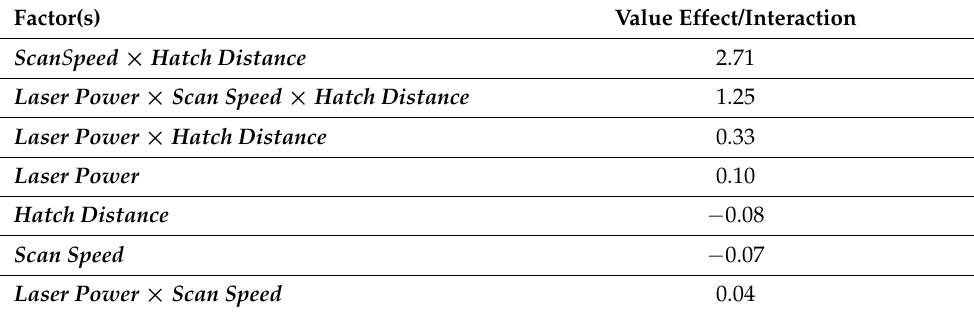
Table 3. Effects and interactions of surface